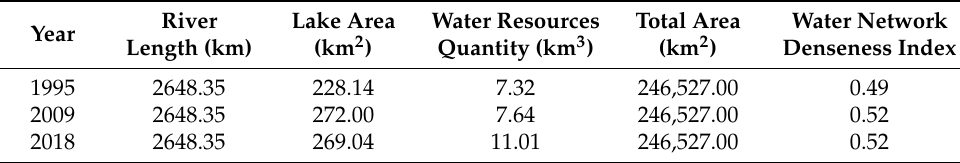
Table 7. Results of the water network denseness index in